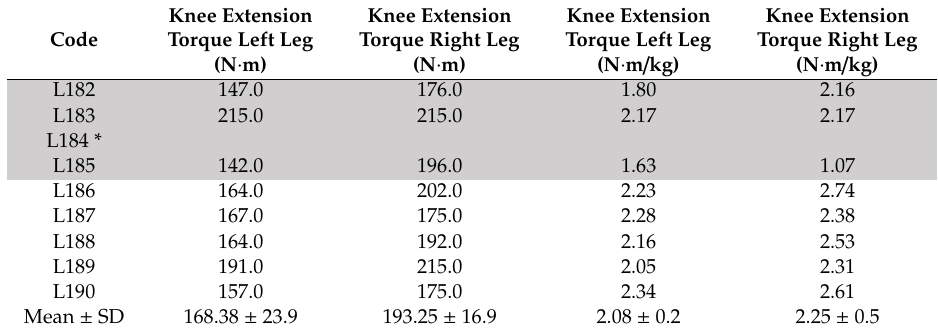
Table 3. Muscle performance of trained subjects.